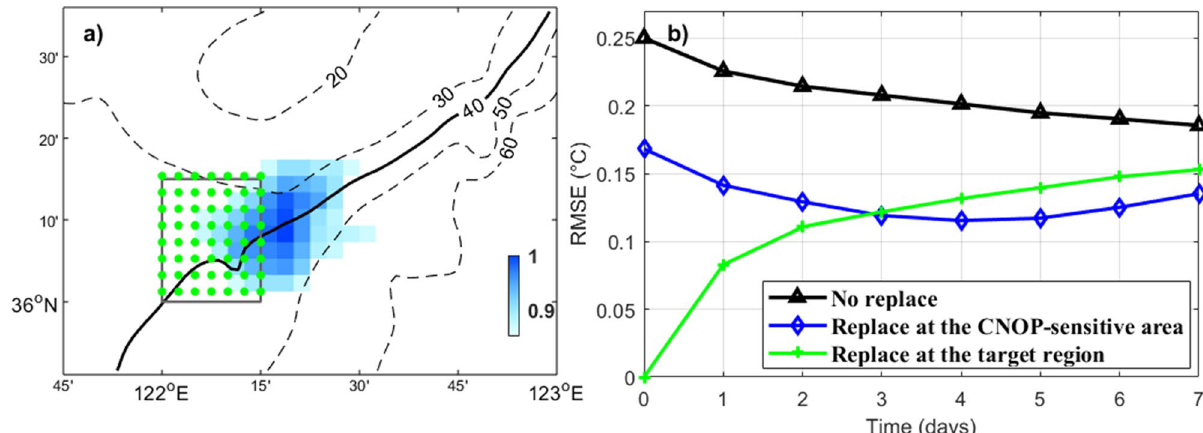
Figure 3. ( a ) Location of the identified sensitive area for the last climatology year (blue color). The CNOP are normalized according to their maximum value. The gray box indicates the location of the target region and the green dots denote the grid points in the target region. The 20–60 m isobaths are also shown. ( b ) Temporal evolution of the mean temperature profile RMSEs in the target region during the prediction time based on the 20 sets of replace experiments. Figures are plotted using MATLAB R2017a (http:// www. mathw orks.